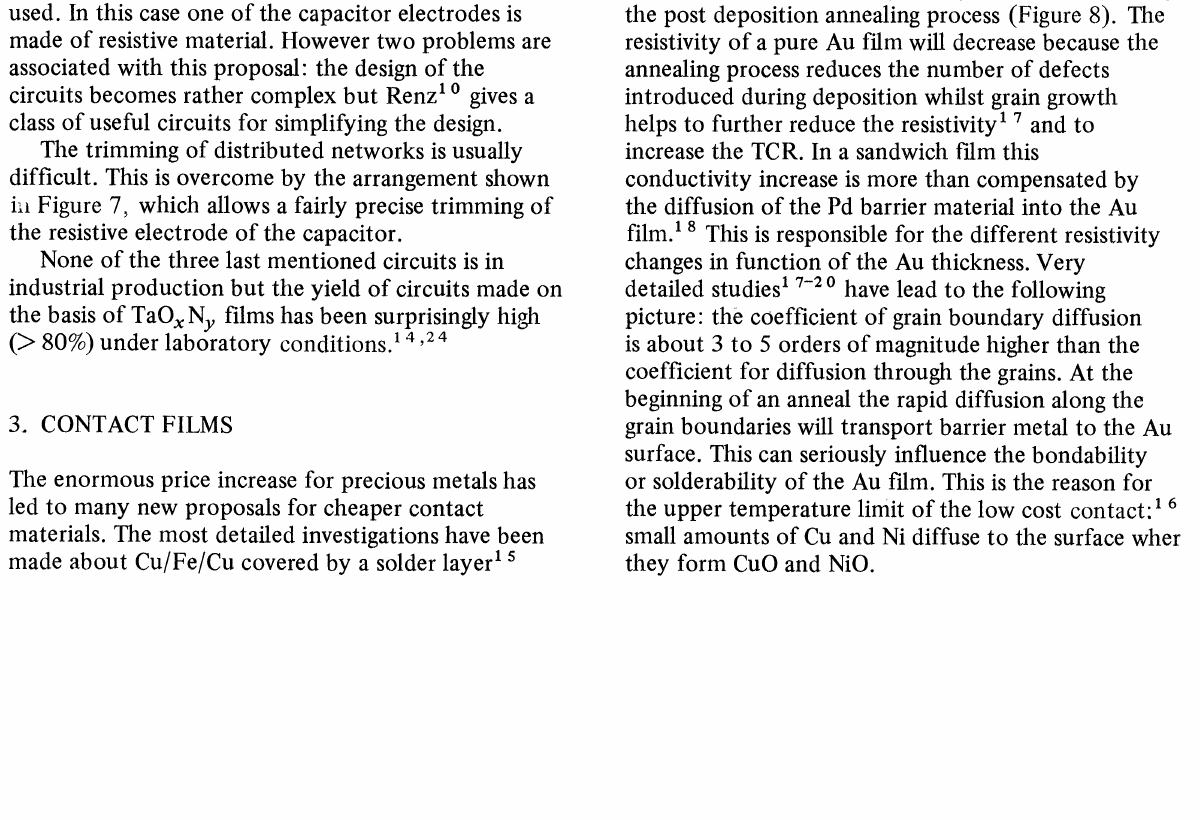
FIGURE 7 Distributed RC element which allows trimming of the resistive bottom electrode" a) resistive electrode, b) dielectric, c) top conductive electrode, d) trim cuts.